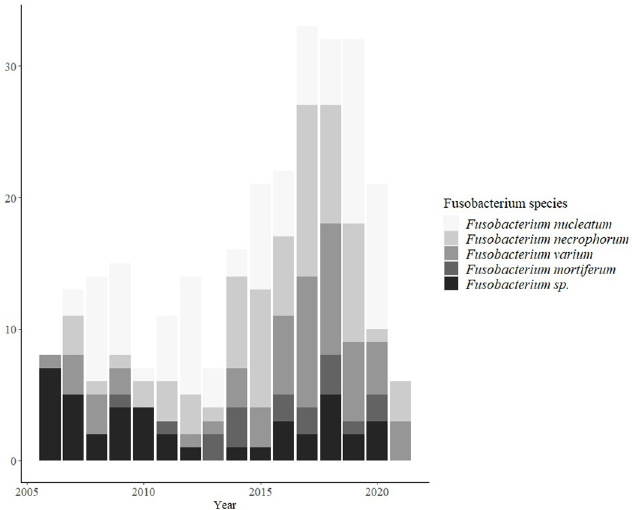
Fig 1. Year-wise distribution of cases and proportion of each